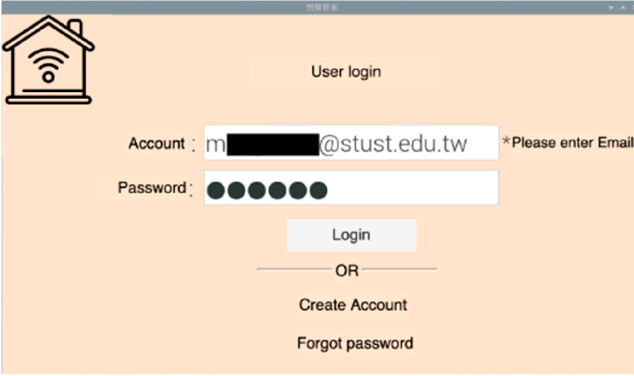
Figure 8. User operation interface.